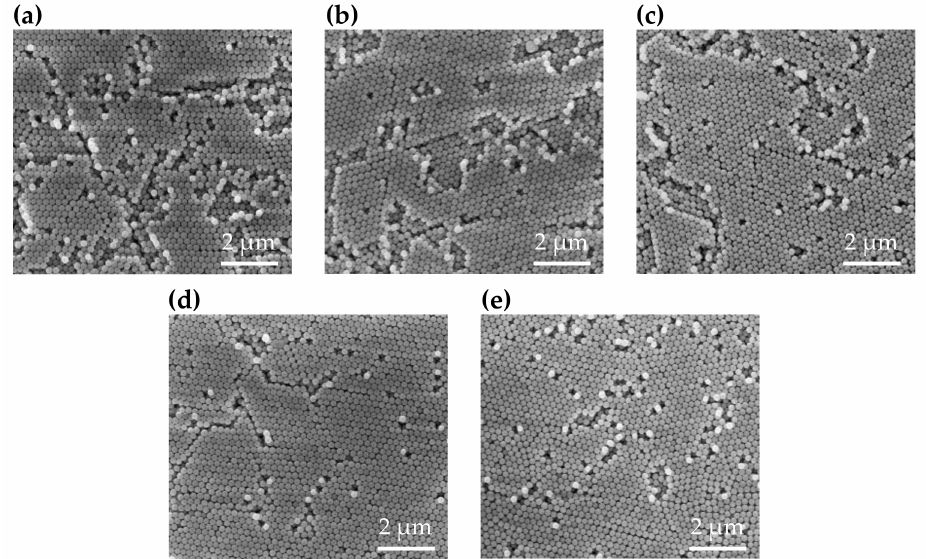
Figure 4. SEM images of a structure stacked with a 30 wt % silica colloidal solution and under centrifugal forces of ( a ) 0; ( b ) 7; ( c ) 14; ( d ) 18; and ( e ) 21